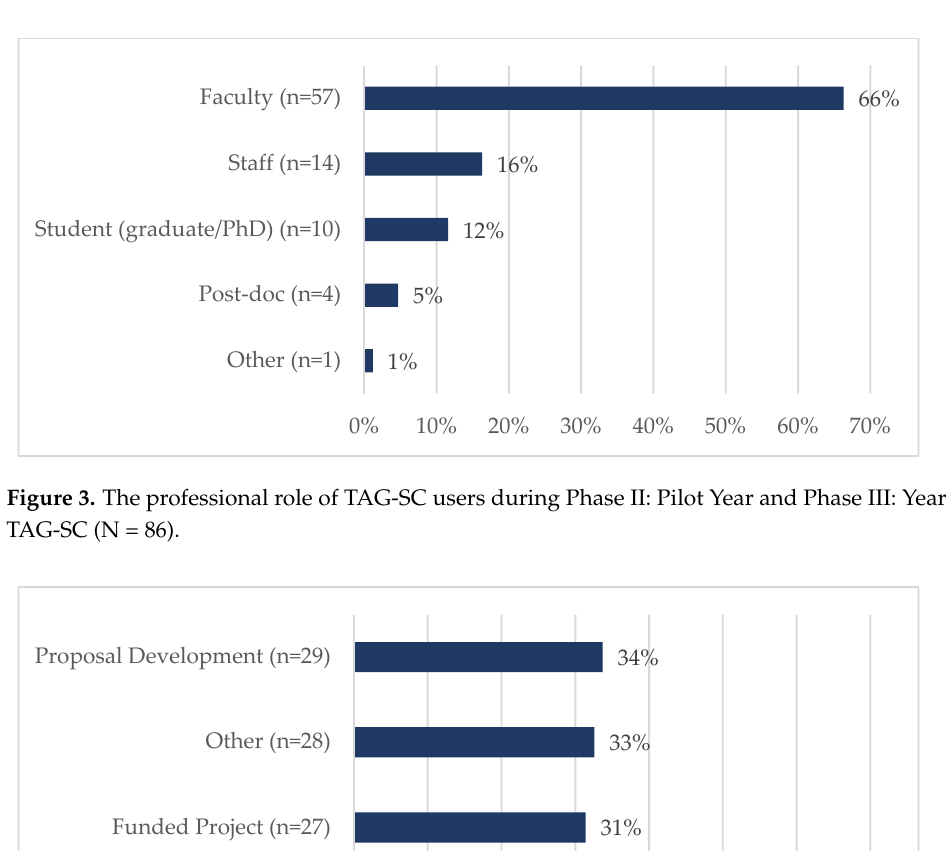
Figure 2. ESI TAG-SC user rates during Phase II: Pilot Year and Phase III: Year 1 of TAG-SC (N = 86).